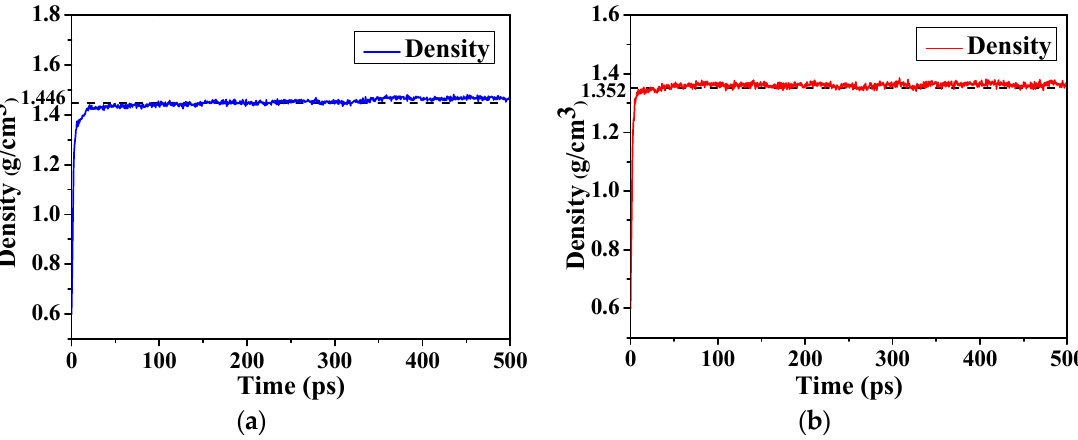
Figure 6. Density variation over time calculated using ( a ) the COMPASS force field and ( b ) the PCFF force field.